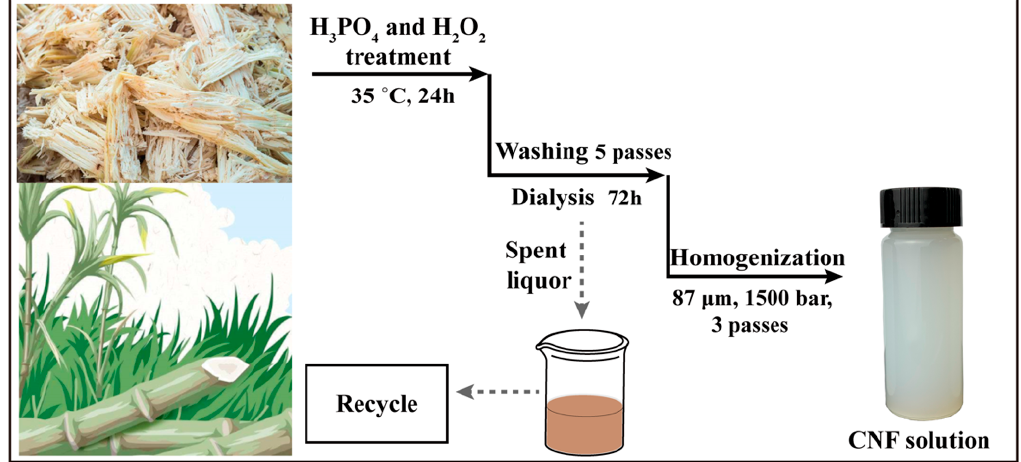
Figure 1. Schematic diagram of the extraction of cellulose nanofibers (CNFs) from bagasse by H 4 PO 3 and H 2 O 2 treatment.